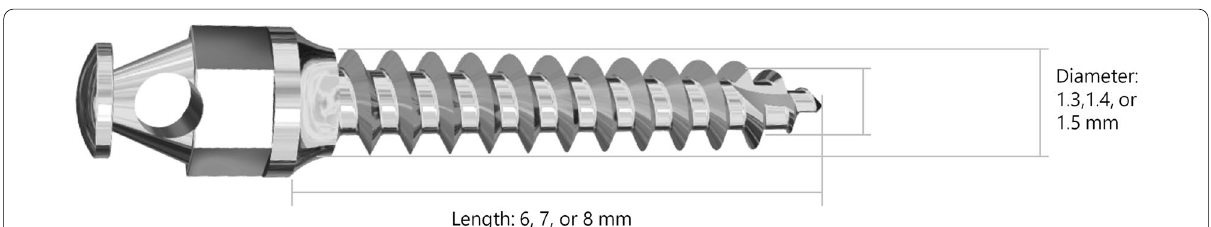
Fig. 2 Shape and size of the microimplants used in this study